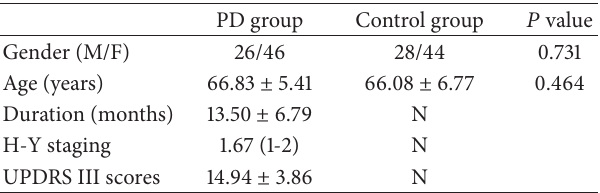
Table 1: General characteristics of study